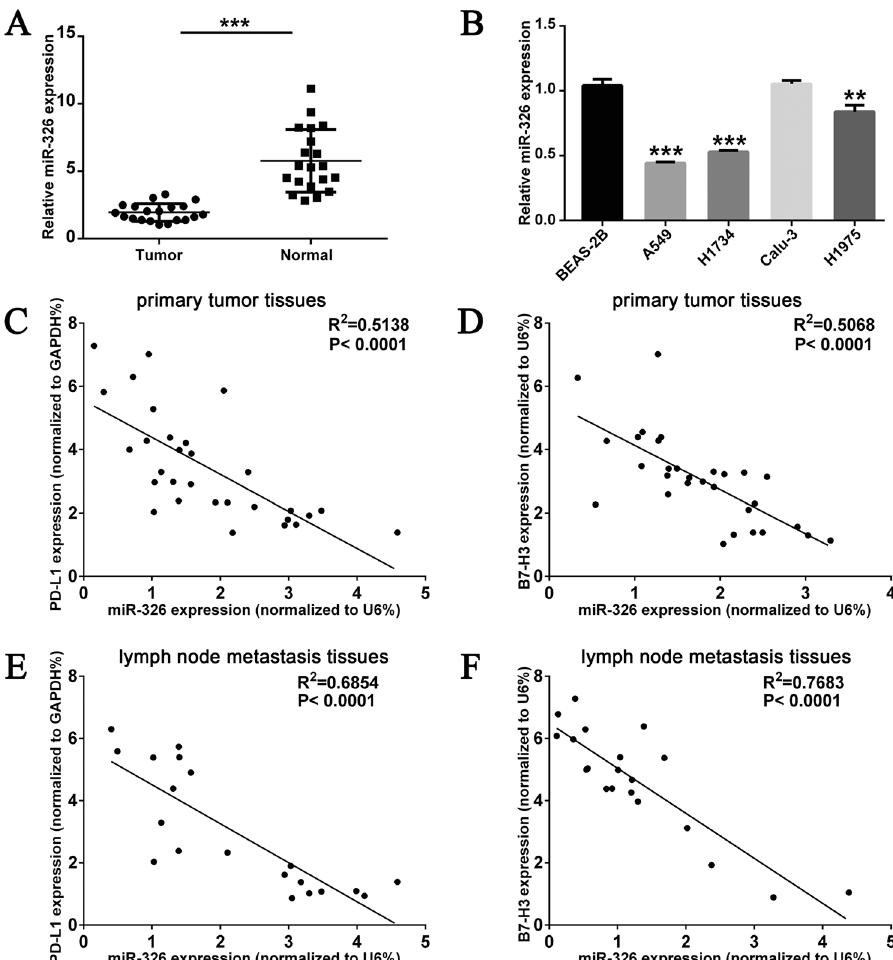
B Transcription level of miR-326 in normal lung epithelial cell line BEAS-2B and LUAD cell lines A549, H1734, Calu-3, and H1975 ( n = 3). Dot plot of the concordant miR-326 and PD-L1 ( C ), B7-H3 ( D ) RNA levels in LUAD primary tumor tissues ( n = 30). Dot plot of the concordant